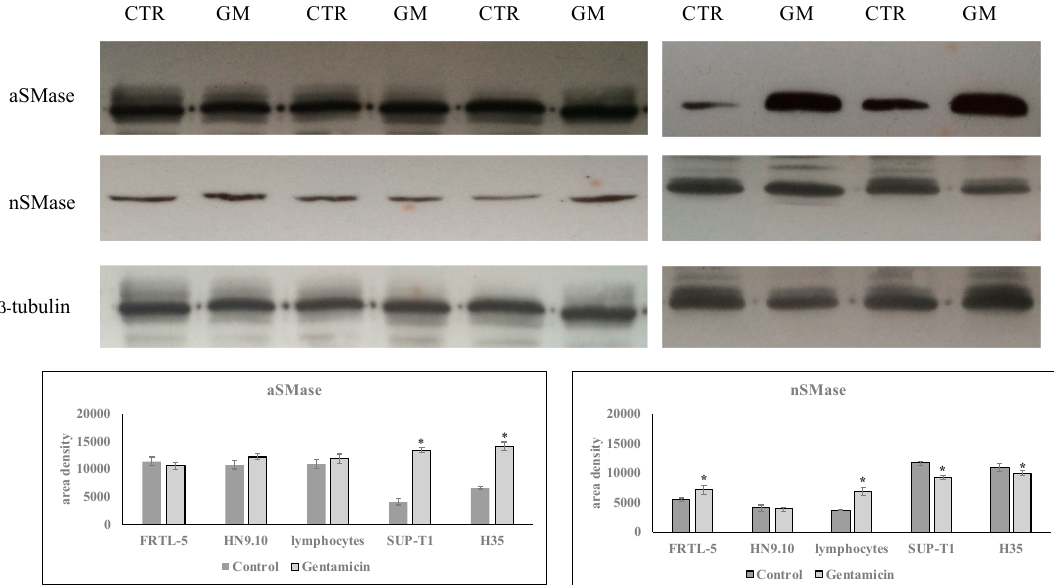
Figure 7. Effect of gentamicin on aSMase and nSMase protein expression. Experiments were performed in control and experimental FRTL-5, HN9.10, lymphocytes, SUP-T1, and H35 cells, collected 24 h after 1.5 mM GM treatment. ( a ) Immunoblots of proteins were probed with anti-aSMase and anti-nSMase and visualized by enhanced chemiluminescence (ECL). β -tubulin was used as loading control. ( b ) The area intensity was evaluated by densitometry scanning and analysis with ImageJ program, the data represent the mean ± SD of three experiments performed in duplicate (significance, * p < 0.001 versus control sample).